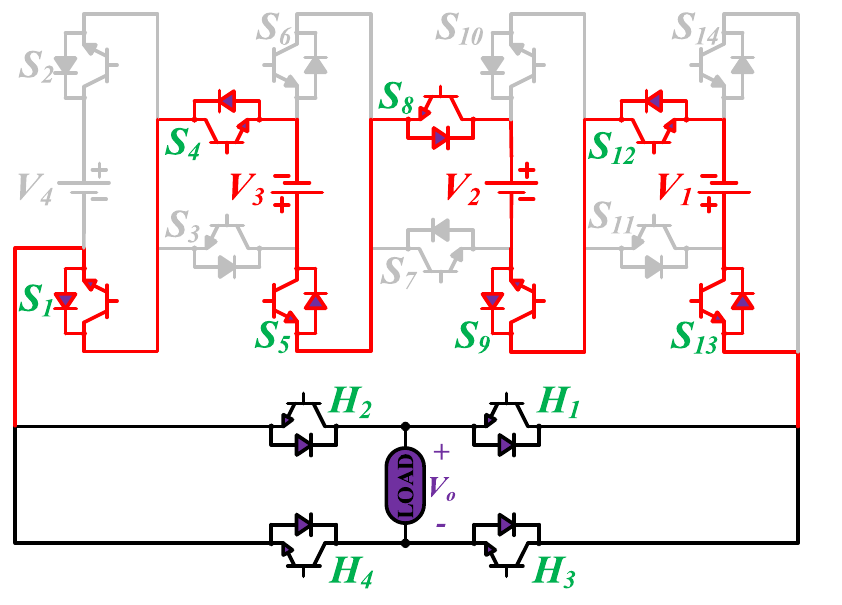
voltage sources V : V : V : V as 270 V:90 V:30 V:10 V. The output voltage waveform with 4 3 2 1 zoomed-in levels is shown in Fig 14. The PWM and the output voltage waveform for resistive, inductive, capacitive, and dynamic load are shown in Figs 15–19 respectively. The harmonic analysis is carried out, and the THD of the output voltage for 81-level MWMLI is computed and is shown in Fig 20. The expressions for the number of DC sources N power switches N in terms of the number of voltage levels N S